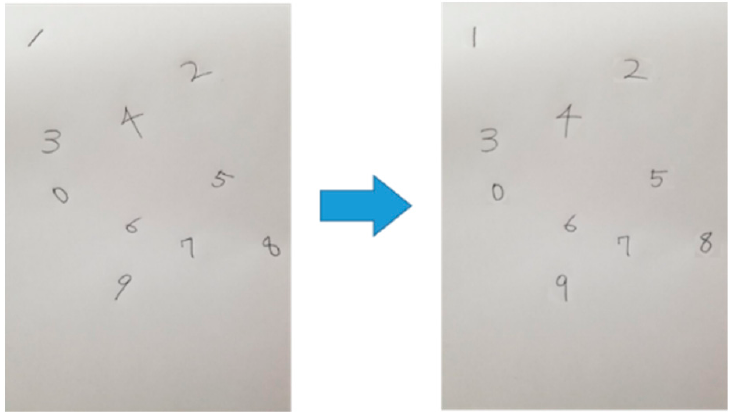
Figure 12. Example of the tilt correction of digits written in independent positions.